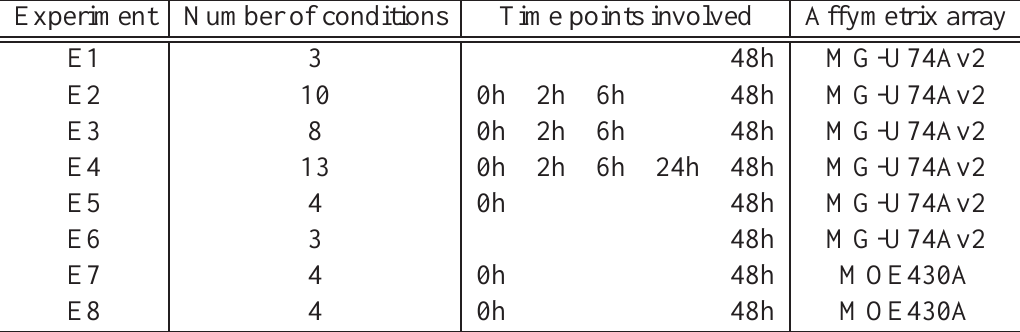
Table 1: Summary of the experiments used in the present study. In experiment E3, only Th1 samples were measured at 48 h. In the other experiments and time points (except 0h), all three treatments Th0, Th1 and Th2 were